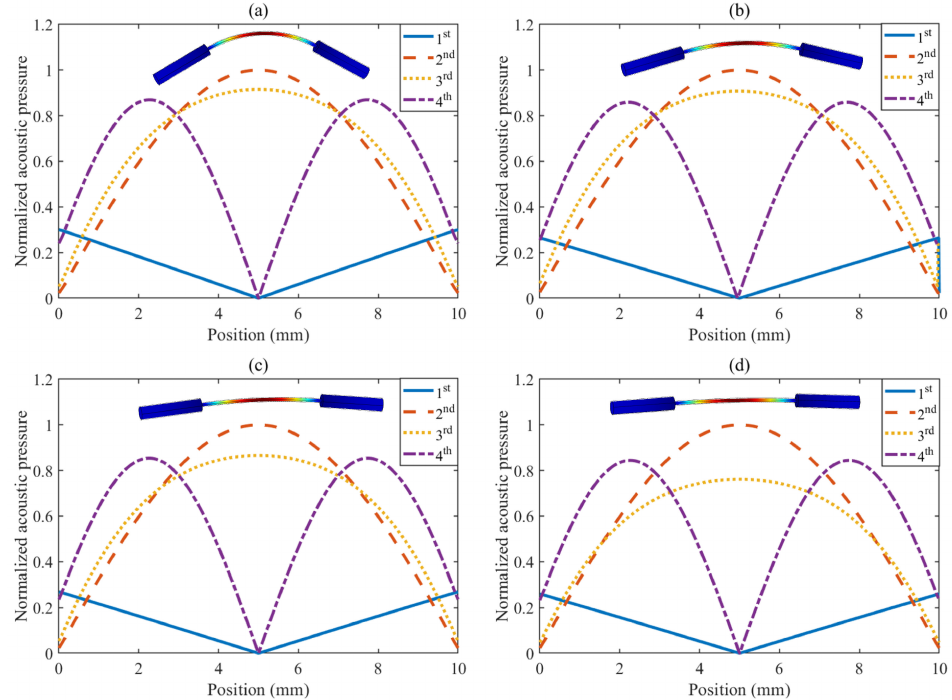
Figure 7. The acoustic modes along the HCF central axis of different eigenmodes with respect to varied bending radii: ( a ) 10 mm; ( b ) 20 mm; ( c ) 50 mm; ( d ) 100